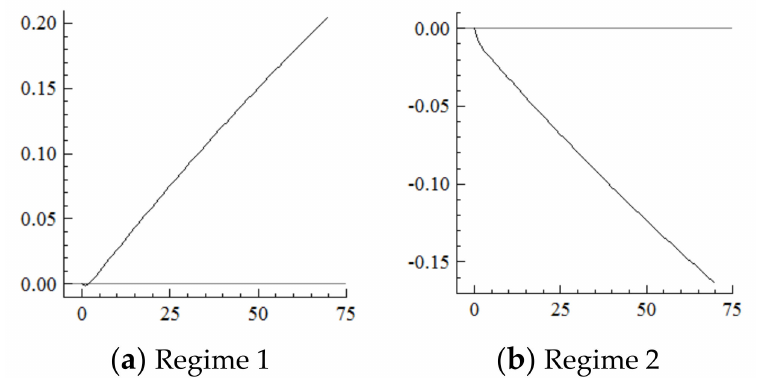
Figure 5. Cumulative Impulse Response of the Capital Stock to Population Aging Shocks.